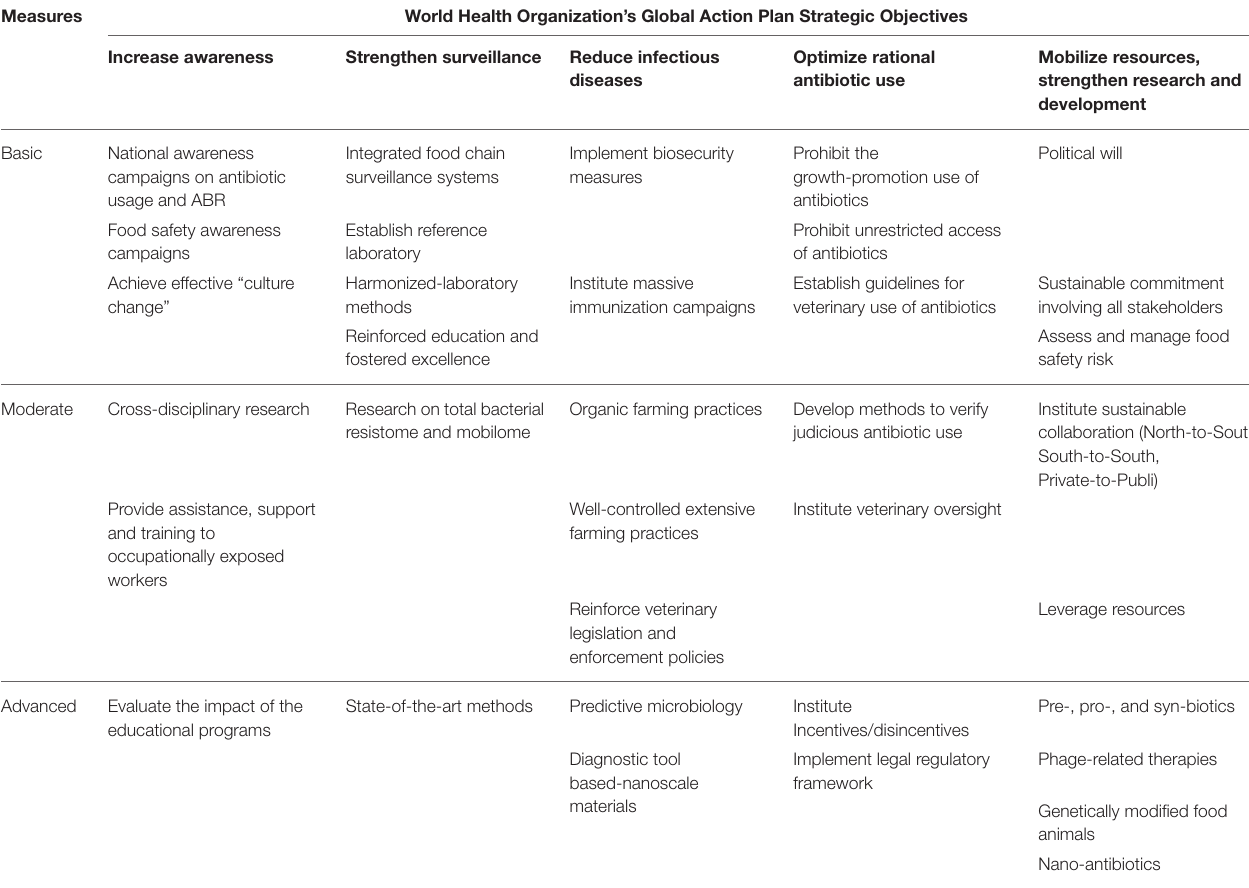
TABLE 3 | Summary of prevention and containment measures of antibiotic resistance from farm-to-fork.